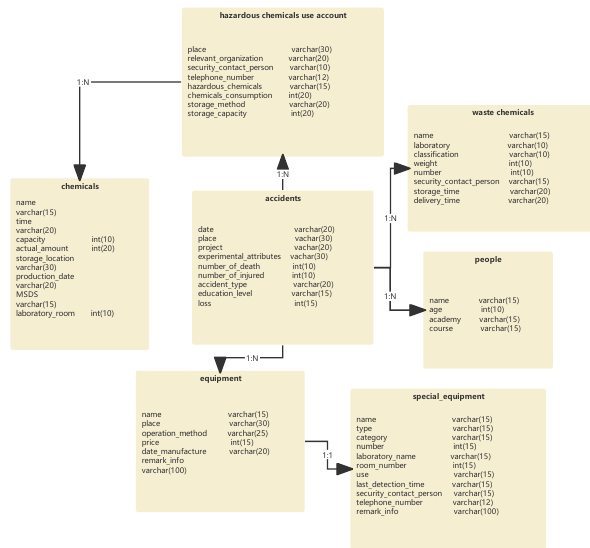
Figure 8. Structure of laboratory accident querying in DRC.